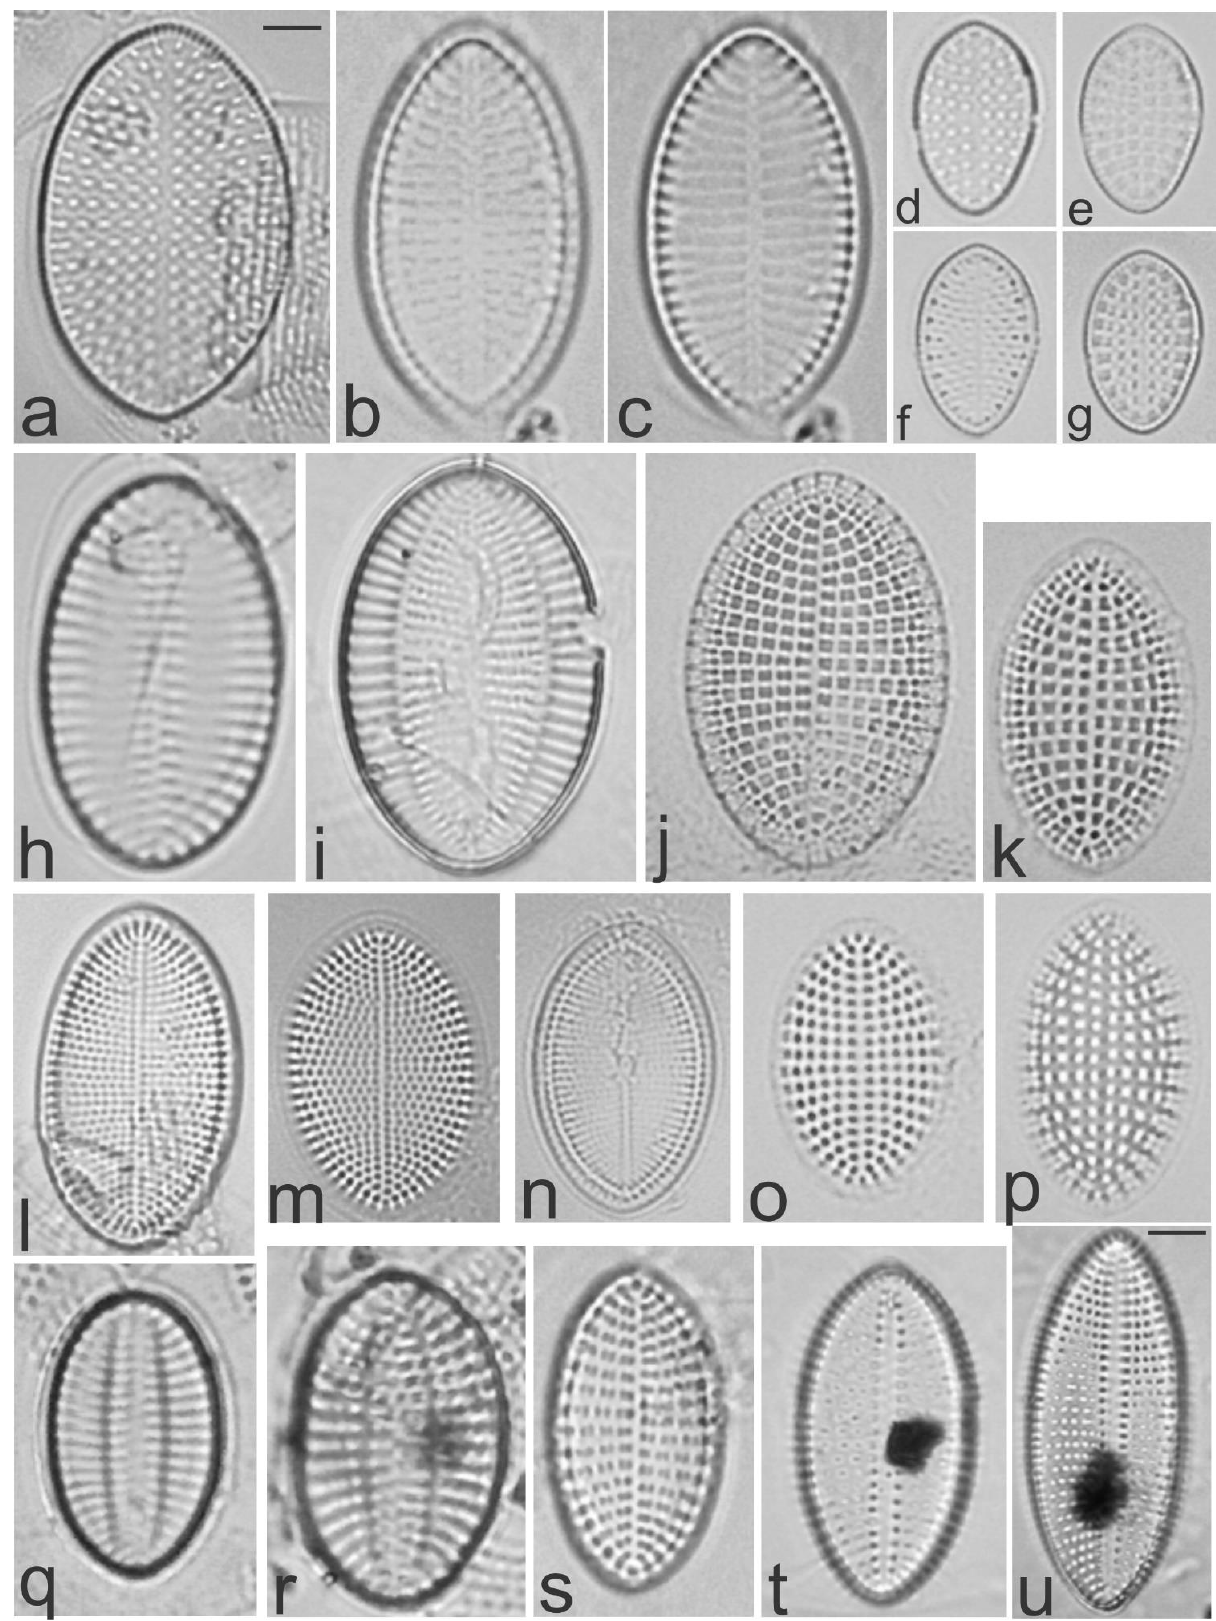
Figure 14. ( a – g ) Cocconeis guttata ; ( h ) C. hauniensis ; ( i ) C. latecostata ; ( j , k , p ) C. speciosa ; ( l – n ) C. placentula ; ( o ) C. scutellum var. parva ; ( q , r ) C. peltoides ; ( s ) Amphicocconeis disculoides ; ( t , u ) A. debesii . Scale bar = 5 μm.